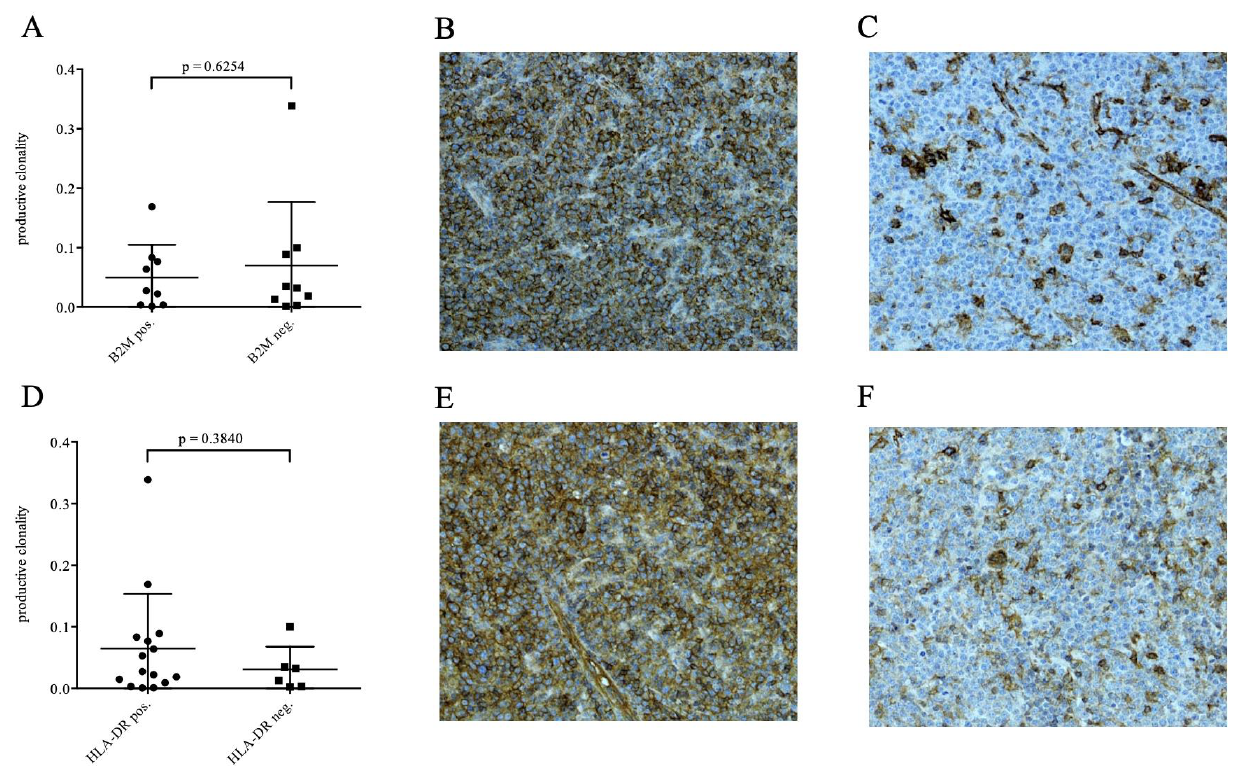
Figure 1. Immunohistochemical expression of HLA class I antigen compound beta2microglobulin was observed to be